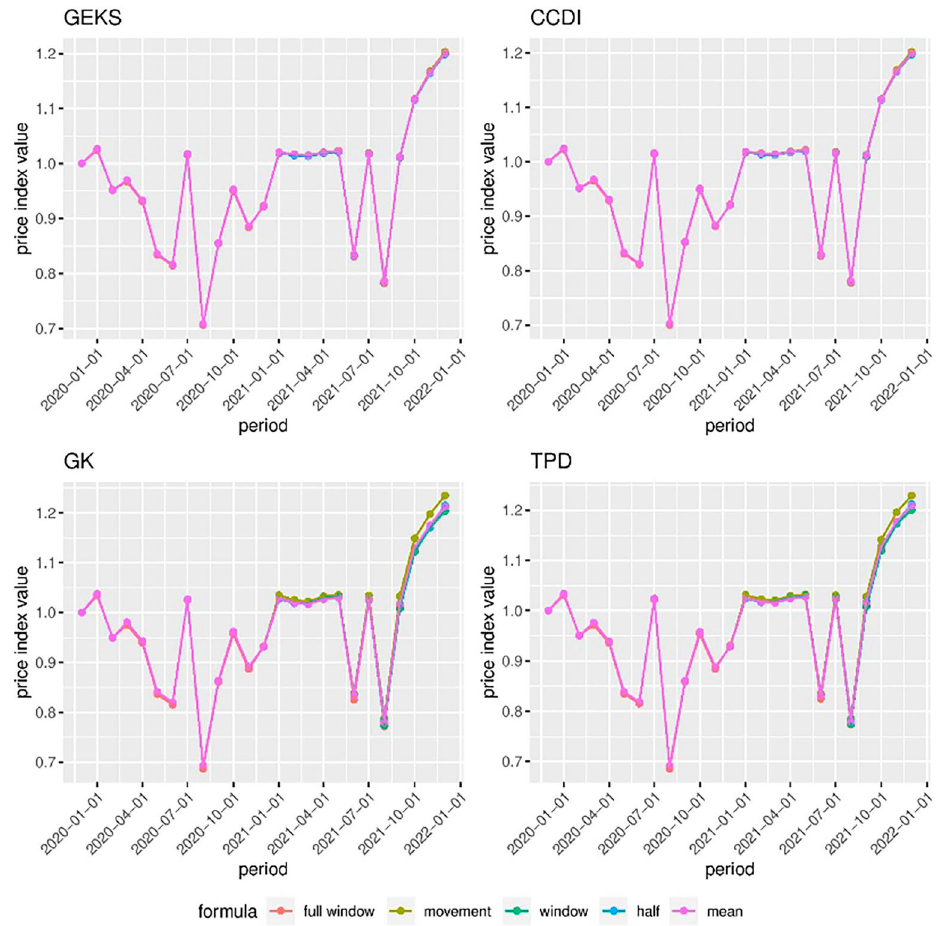
Figure A1. Comparison of c IDT G indices (splicing methods vs full time indices) for sugar